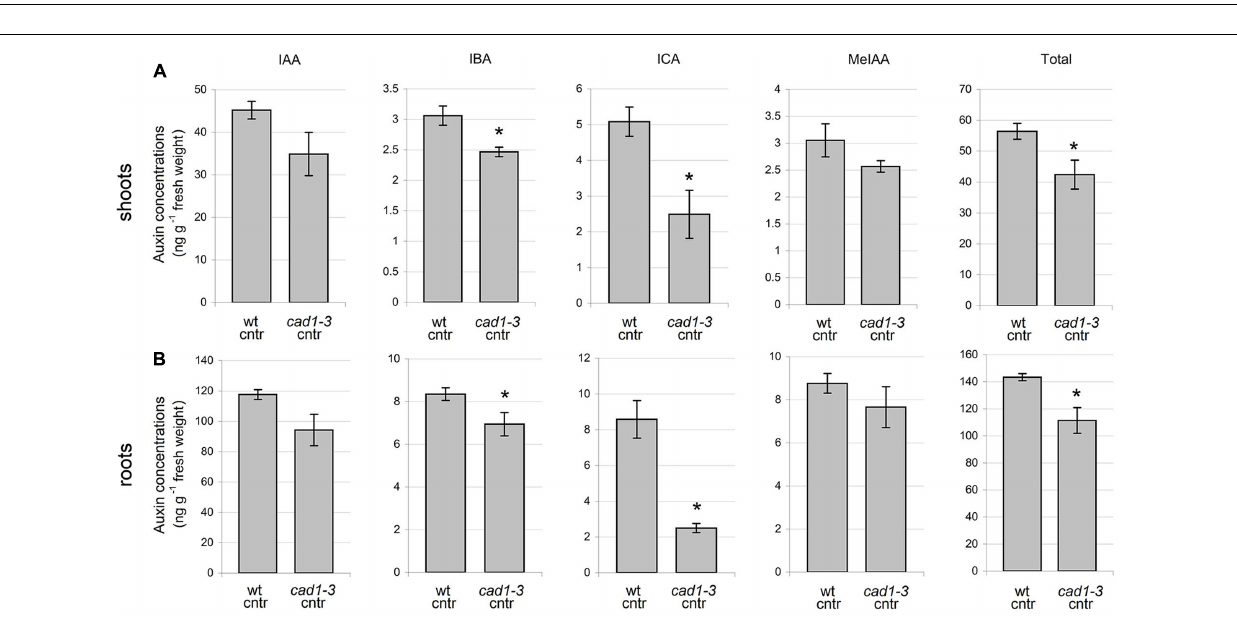
FIGURE 8 | Levels of kaempferol 3,7 dirhamnoside (A) and quercetin hexoside rhamnoside (B) in shoots of wt and cad1-3 plants, grown under control conditions (cntr) or exposed to 36 µ M of CdCl 2 for 24 h. The metabolite relative content is reported as ion counts (arbitrary units, a.u.). n = 5, error bars indicate SE; statistics as in Figure 1 .